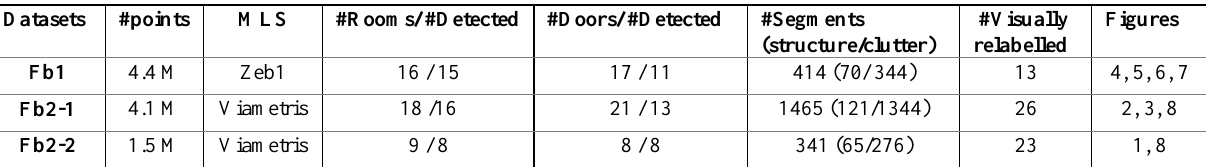
Table 1: Details of the datasets, and the number of detected rooms and doors. The sixth column indicates the number of planar segments with supporting points more than 500 and in the brackets number of permanent structure and clutter segments. The last column shows how many of the segments are visually identified and